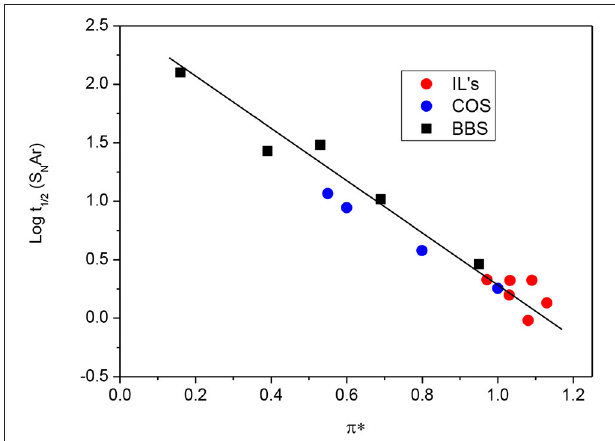
FIGURE 8 | plot of log t 1 / 2 against π * parameter, obtained for the degradation of 1 by S N Ar route in several solvents.